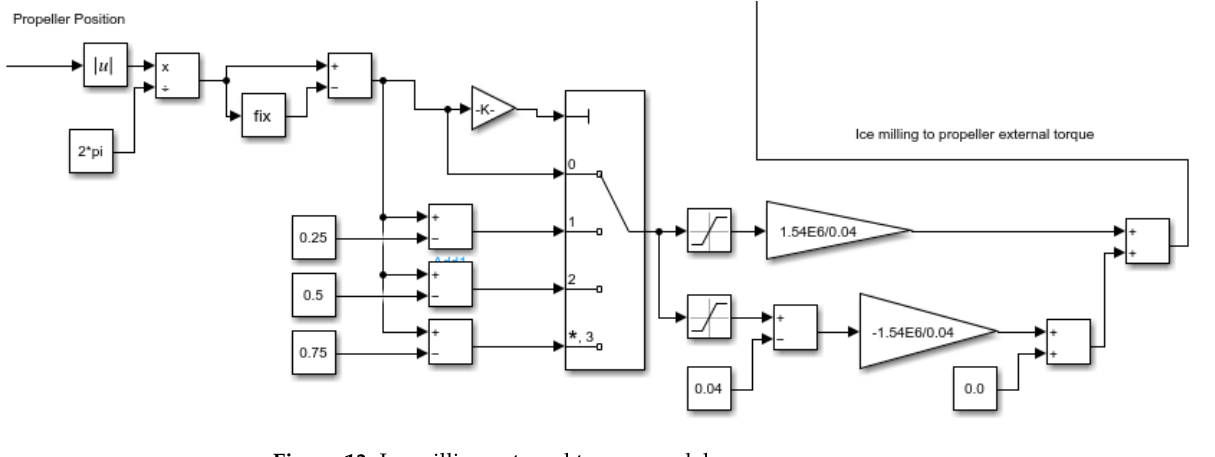
Figure 13. Ice milling external torque model.